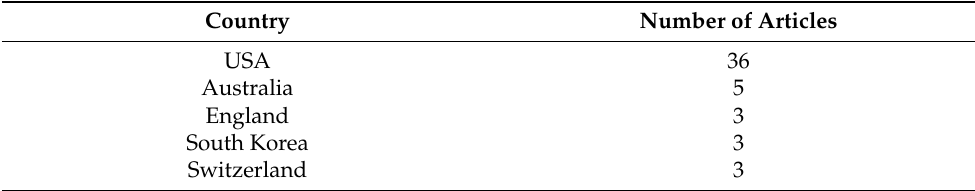
Table 2. Top 5 most productive countries.